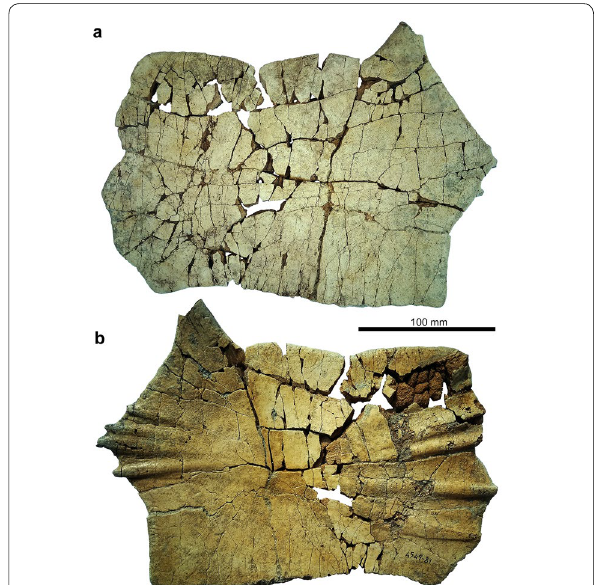
Fig. 4 Pan-Cheloniidae indet. from Cessaniti; plastral material. Right hyoplastron (MSNC 4549–81) in ventral ( a ) and dorsal ( b ) views